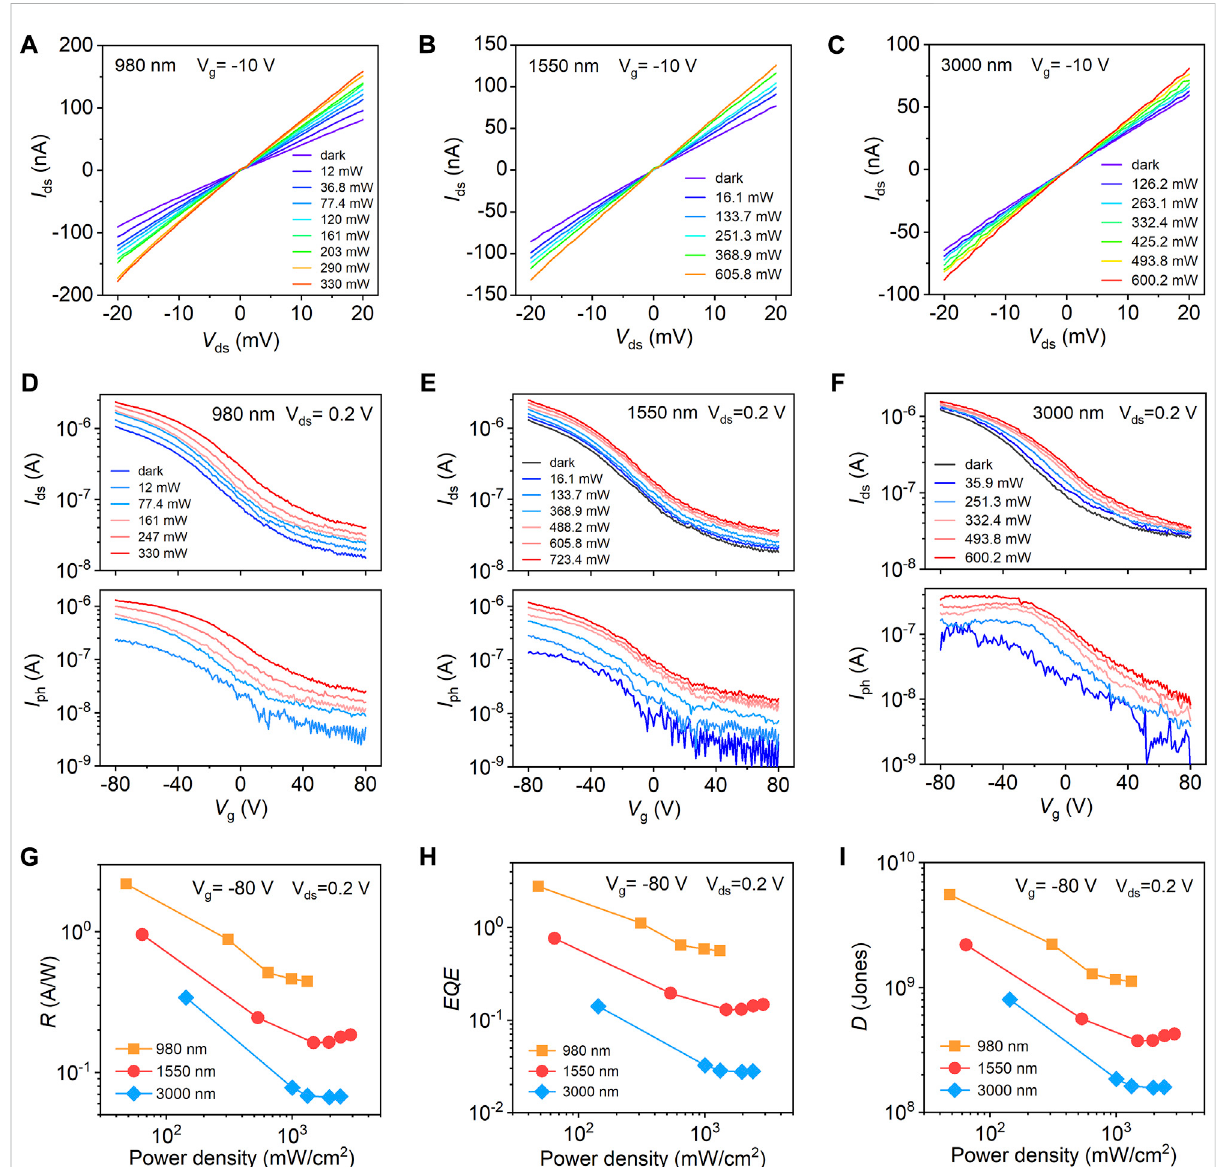
FIGURE 5 The I ds - V ds curves of Te phototransistors under varying 980 nm (A) , 1,550 nm (B) , and 3,000 nm (C) illumination power. The gate voltage V g is fi xed at -10 V. (D – F) Transfer characteristics (upper part) and gate-dependent net photocurrent I wavelengths. (G – I) Illumination power-dependent photoresponsivity ( R ), external quantum ef fi ciency ( EQE ), and detectivity D for different wavelengths at V g = − 80 V and V ds = 0.2